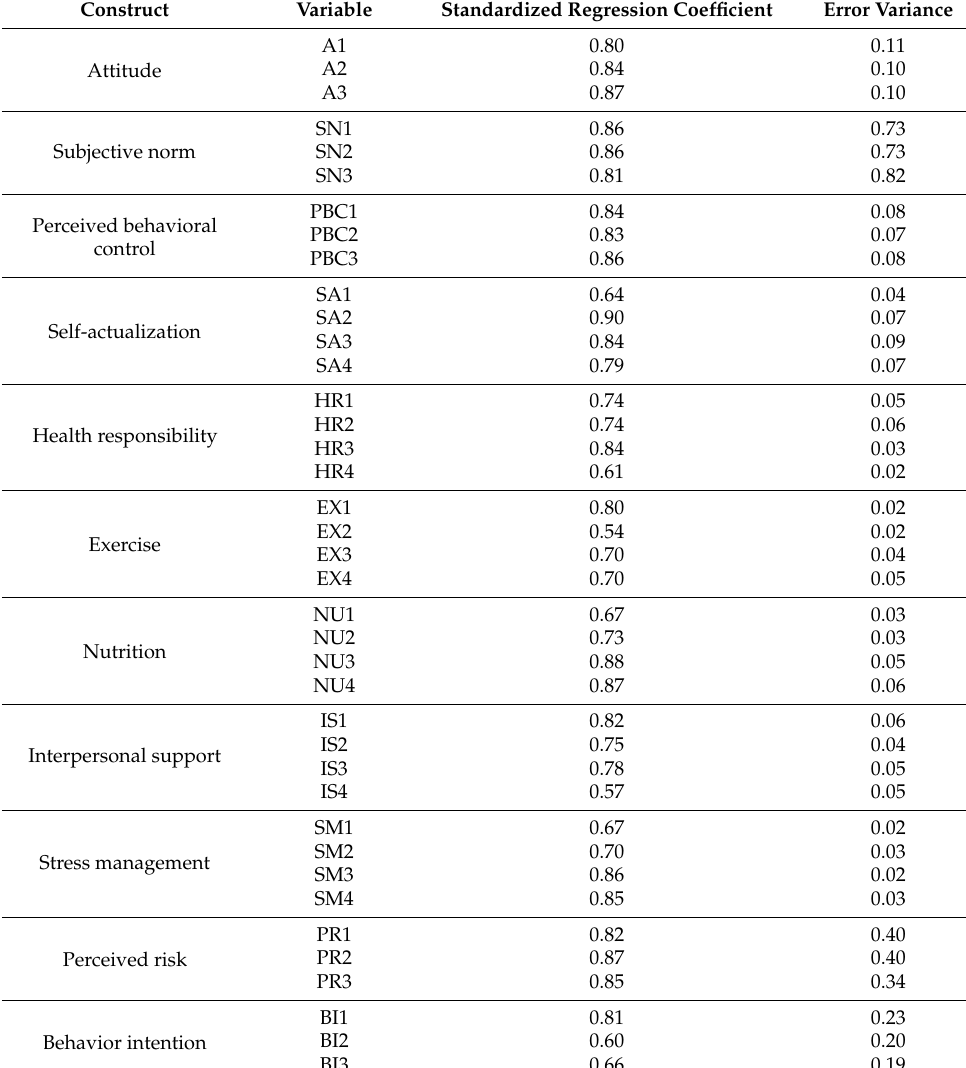
Table 2. The test of offending